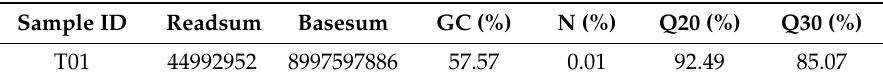
Table 1. Raw data of M. roridum